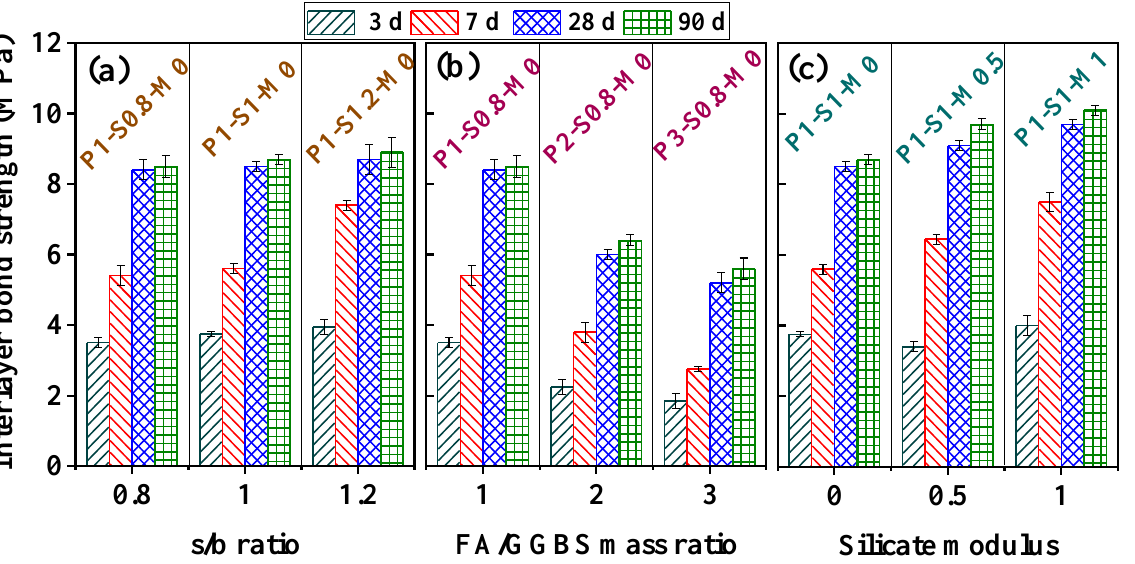
Figure 9. Interlayer bond strength of 3D-AAFS mortar. ( a ) effect of s/b ratio, ( b ) effect of FA/GGBS mass ratio, ( c ) effect of silicate modulus.